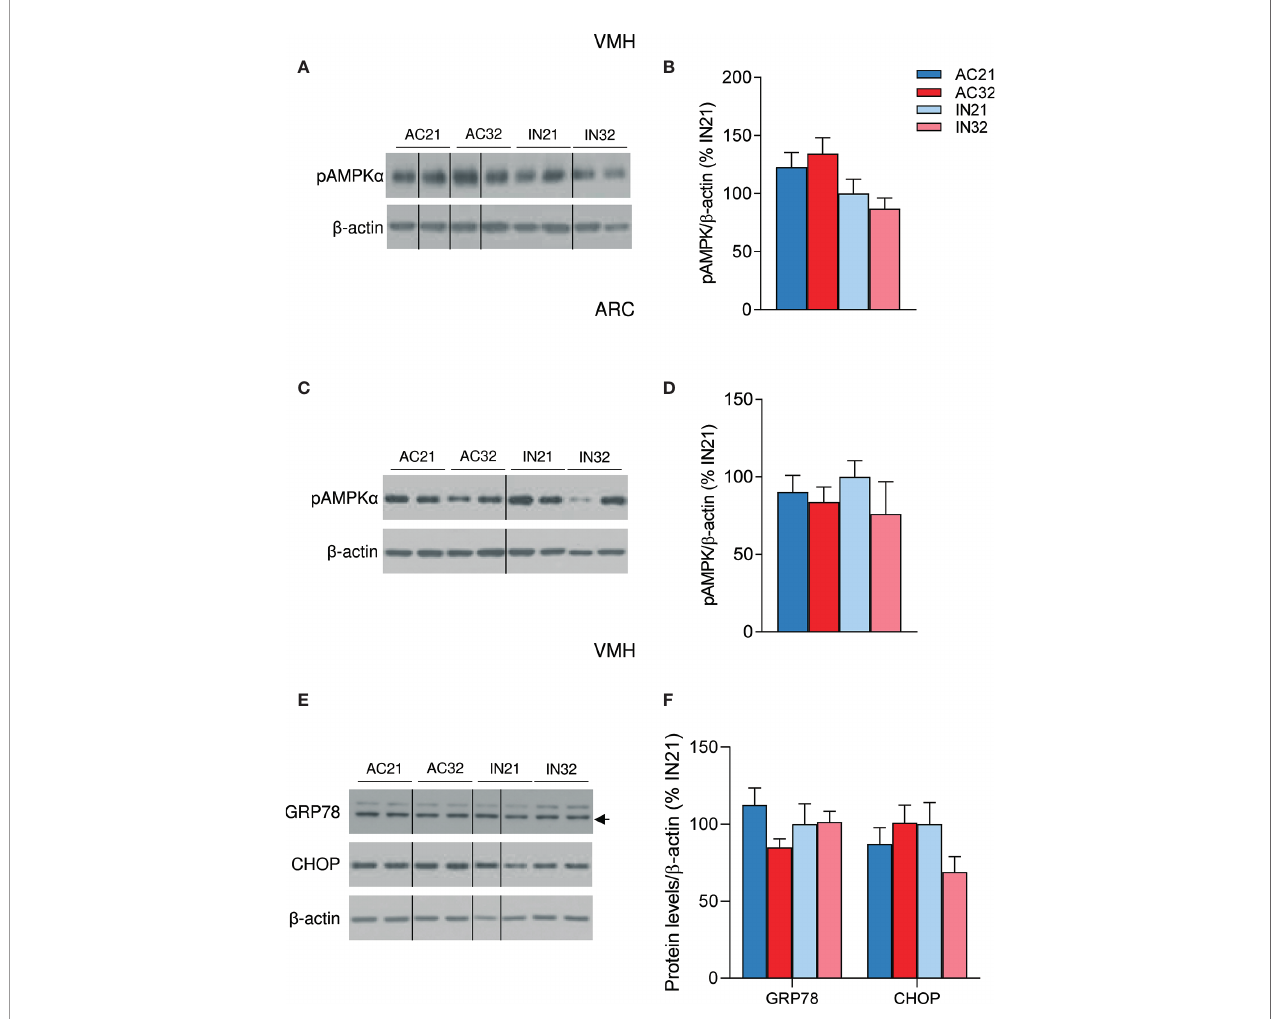
FIGURE 4 | Effect of ABA and temperature on AMPK and ER stress in the VMH and ARC. (A, B) Protein levels of pAMPK a in the VMH (n = 7-10 rats/group) (C, D) Protein levels of pAMPK a in the ARC (n = 7 rats/group) (E, F) Protein levels of GRP78 and CHOP in the VMH (n = 7 rats/group) of active rats at 21°C and 32°C (AC21 and AC32) and inactive rats at 21°C and 32°C (IN21 and IN32). Data expressed as mean ± SEM. The bands in gels from panel (A, C, E) have been spliced from the same original